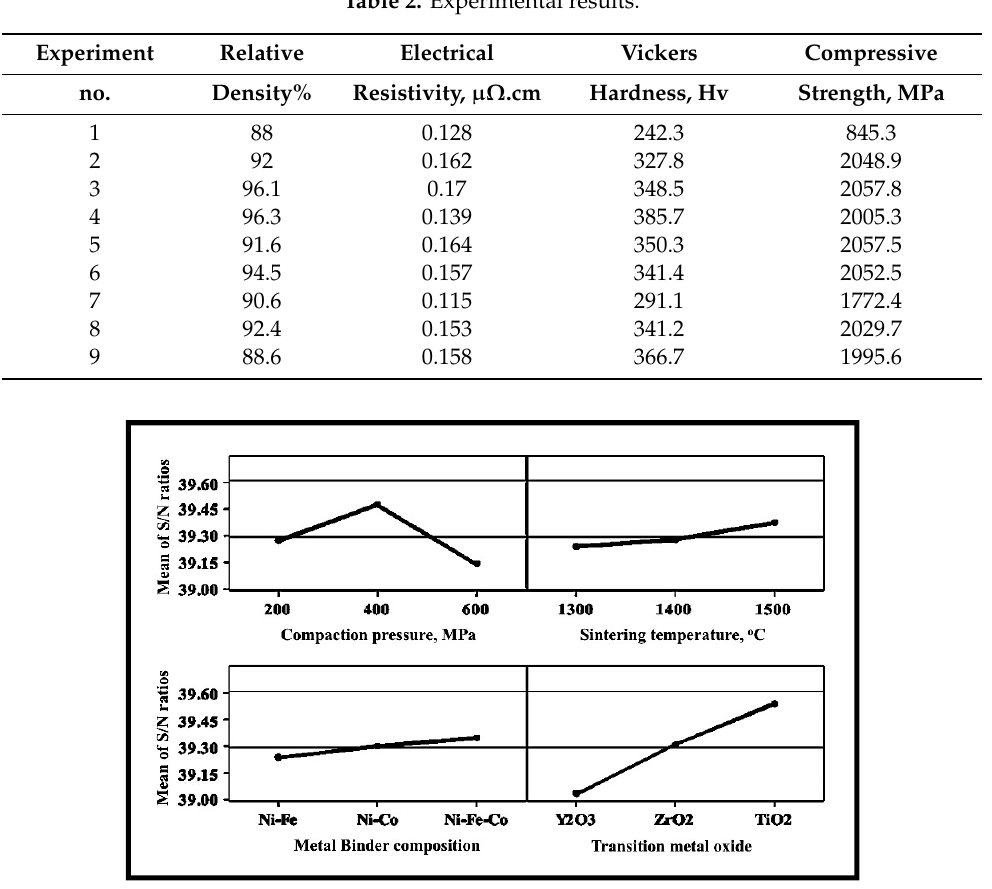
Figure 5. Mean of S/N ratios for density of samples versus levels of input parameters. Figure 5. Mean of S / N ratios for density of samples versus levels of input